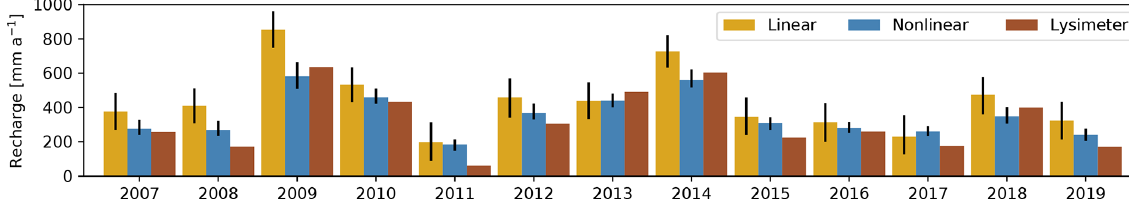
Figure 9. Annual recharge rates as computed by each TFN model and as measured with the lysimeters. The error bars denote the 95% confidence intervals of the recharge estimate.